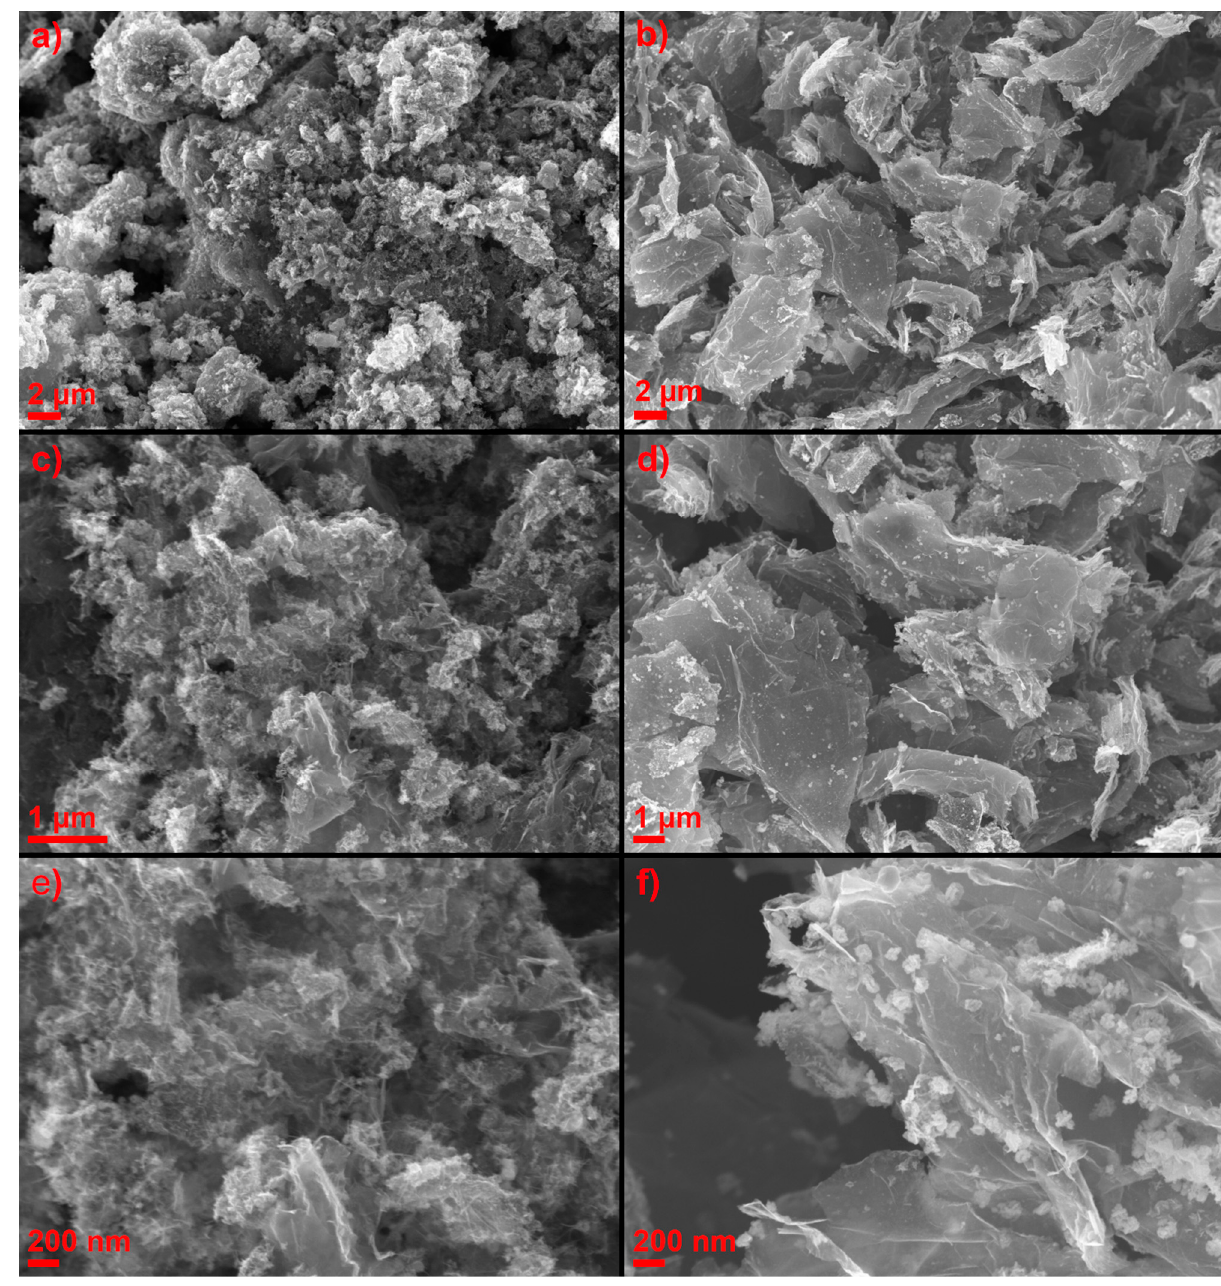
Figure 2. SEM images of Ag-Mn x O y /rGO ( a , c , e ) and Ag-Mn x O y /NGO ( b , d , f ). Table 1. BET results of the Ag-Mn x O y /C